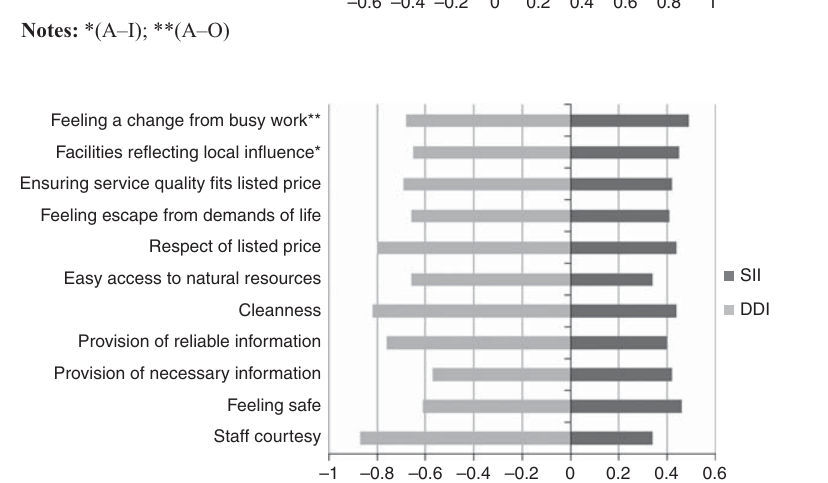
Figure 4. CS Coefficients of